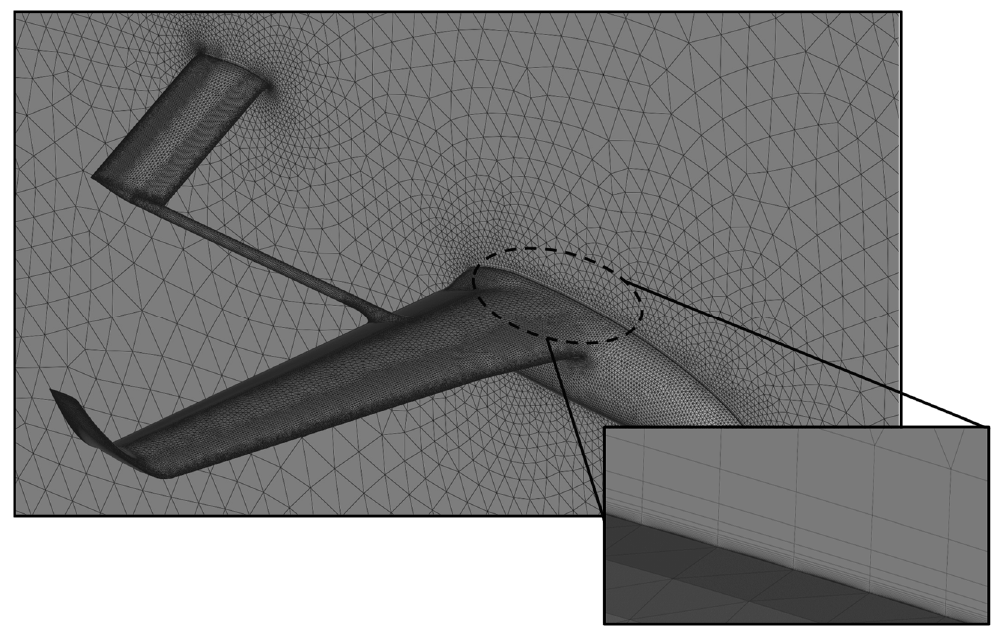
Figure 4. The computational mesh on the surface of the HCUAV RX-1 and detail of the structure-like region.